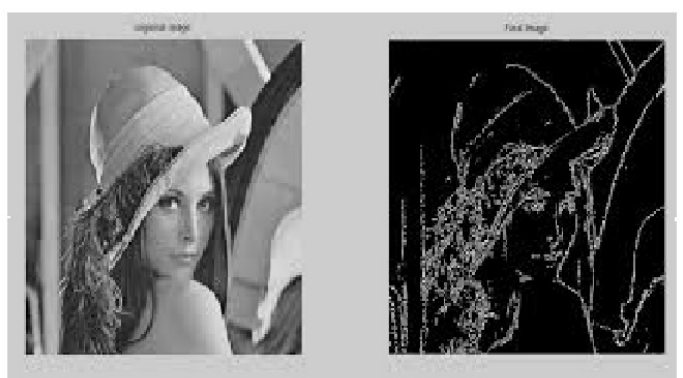
Figure 4. On and Off Kuffler cells.